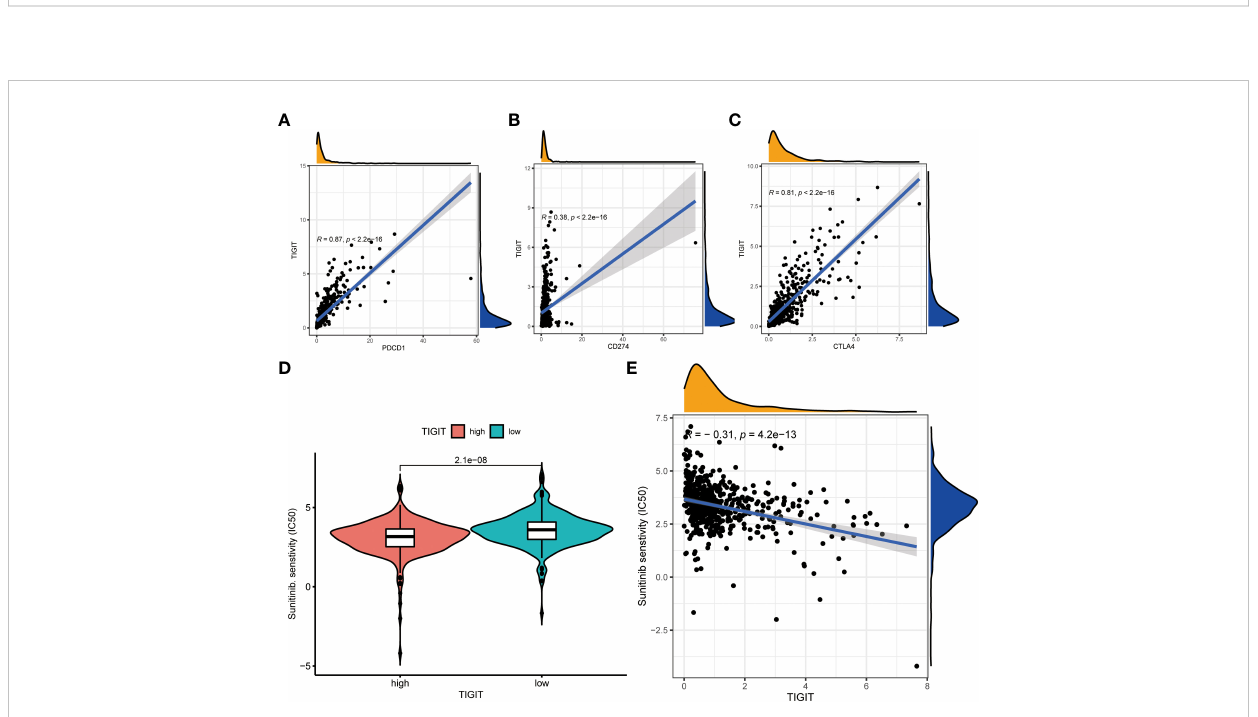
FIGURE 8 The co-expression between TIGIT and other common immune checkpoints and the drug response of sunitinib between high or low TIGIT expression patients. (A) TIGIT was signi fi cantly positive co-expression with PDCD1. (B) TIGIT was signi fi cantly positive co-expression with CD247. (C) TIGIT was signi fi cantly positive co-expression with CTLA4. (D) High expression of TIGIT was associated with a signi fi cantly higher drug sensitivity of sunitinib in KIRC. (E) TIGIT was signi fi cantly positively correlated with the drug sensitivity of sunitinib in